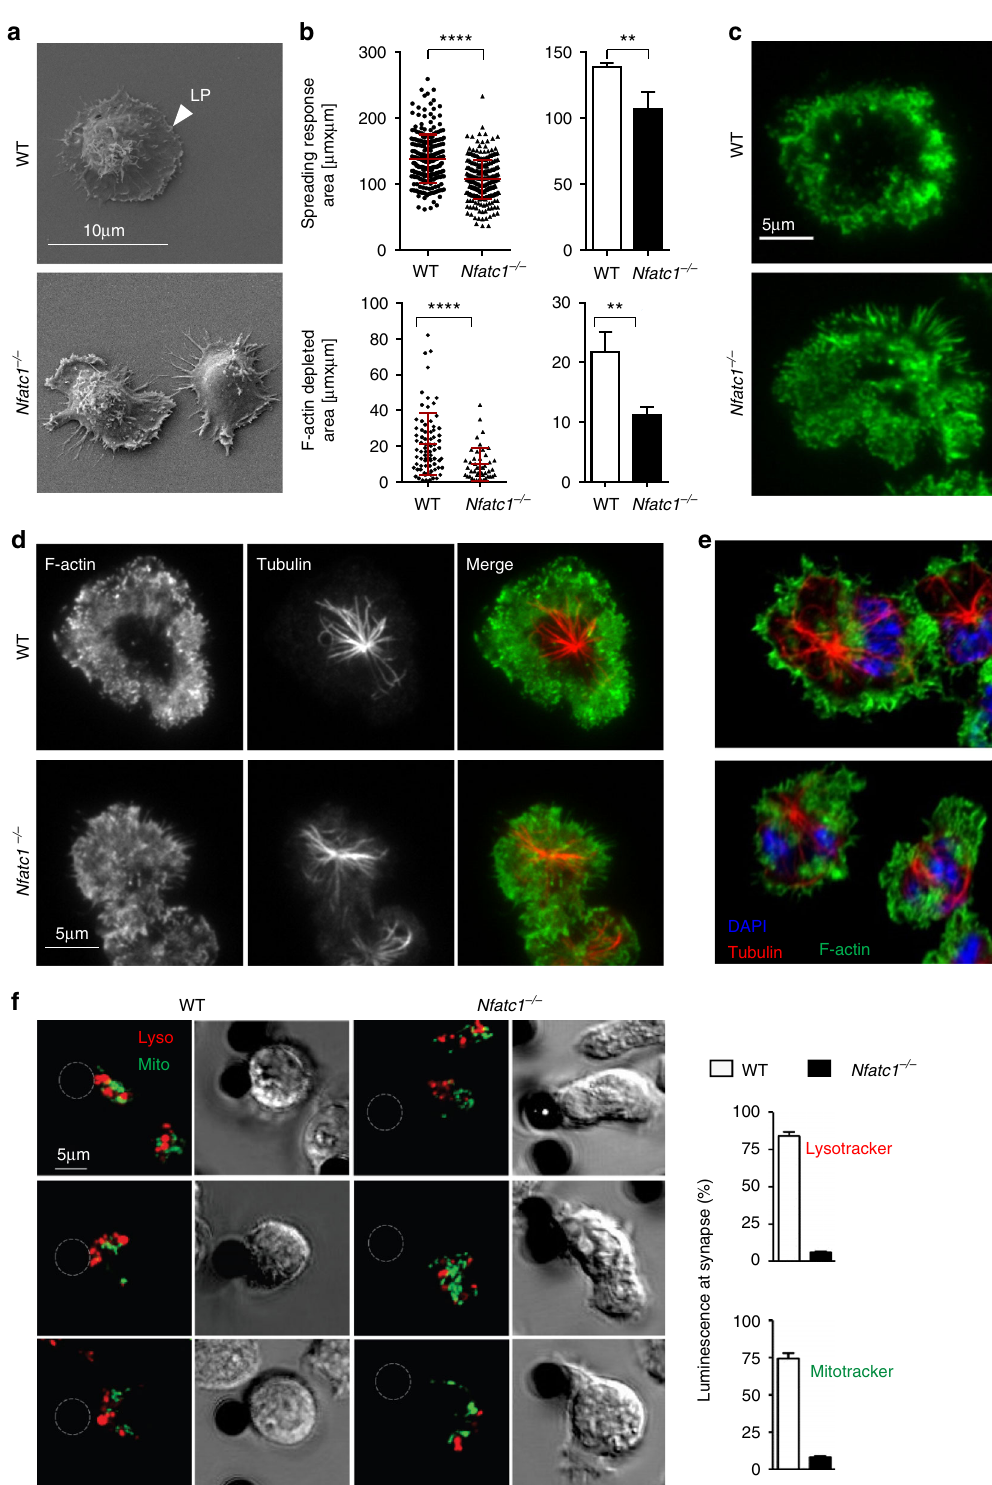
Fig. 1 NFATc1 controls the re-organization of cytoskeleton and polarization of cytosolic organelles. a Spreading of WT and Nfatc1 − / − ( Nfatc1 f/f x CD4-cre mice) CTLs on α CD3/CD28-coated glass slides within 5 min. Scanning electron microscopy. LP, lamellipodium. b Quanti fi cation of data of spreading (above) and F-actin ring formation (below) of CTLs activated for 5 min ( t -test, unpaired, p -value < 0.0001). Left ; each dot/triangle corresponds to one cell. Right ; mean of three independent experiments. c Formation of F-actin rings in WT and Nfatc1 − / − CTLs upon α CD3/CD28 activation within 5 min. TIRF microscopy. d Appearance of MTOC-tubulin near the IS of CTLs upon activation for 5 min. TIRF microscopy. e Organization of F-actin and MTOC-tubulin in CTLs upon activation for 20 min. Confocal microscopy. For scale bar see d . f Repositioning of mitochondria and lytic granules to the IS in living WT but not Nfatc1 − / − CTLs. Left ; analysis by confocal microscopy; overlay of bright fi eld and merged fl uorescence images of lysosomes ( red ) and mitochondria ( green ). The dark dots correspond to beads coated with α CD3/CD28. Right ; quanti fi cation by epi fl uorescence microscopy. The column presentation compiles the data of more than 15 cells from 3 mice